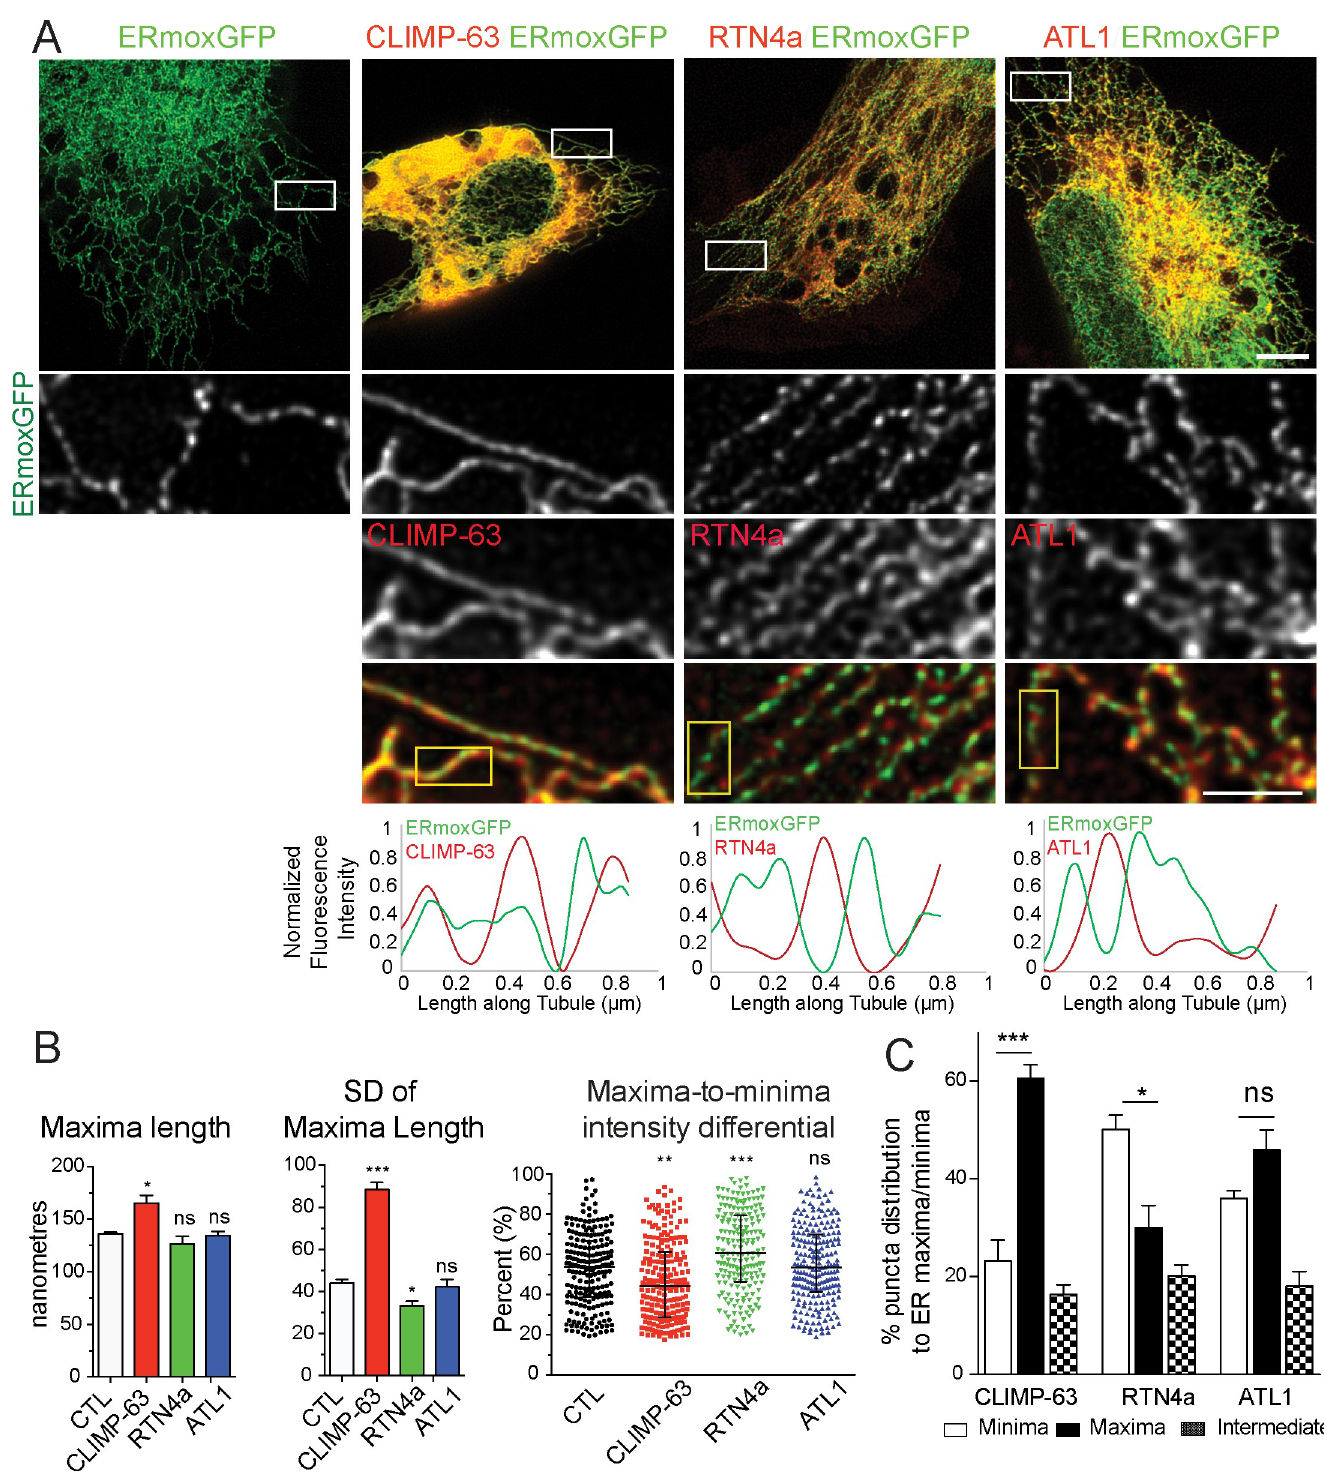
Fig 3. RTN4a and CLIMP-63 overexpression differentially impacts ER nanodomain periodicity. (A) STED images of ERmoxGFP in HT-1080 cells transfected with ERmoxGFP or cotransfected with mCherry-CLIMP-63 (CLIMP-63), mCherry-RTN4a (RTN4a), or mCherry-ATL1 (ATL1). Peripheral ER regions (white boxes) are shown as zooms; line scans of selected tubules in these regions (yellow boxes) are shown with ERmoxGFP in green and ER-shaping proteins in red. Scale bar, 5 μ m; zooms, 2 μ m. (B) Peripheral ER tubule maxima length, variation of maxima length (SD), and maxima-to-minima intensity differential are shown for cells transfected with ERmoxGFP alone (CTL) or cotransfected with mCherry-CLIMP-63 (CLIMP-63), mCherry-RTN4a (RTN4a), or mCherry-ATL1 (ATL1). Significance assessed